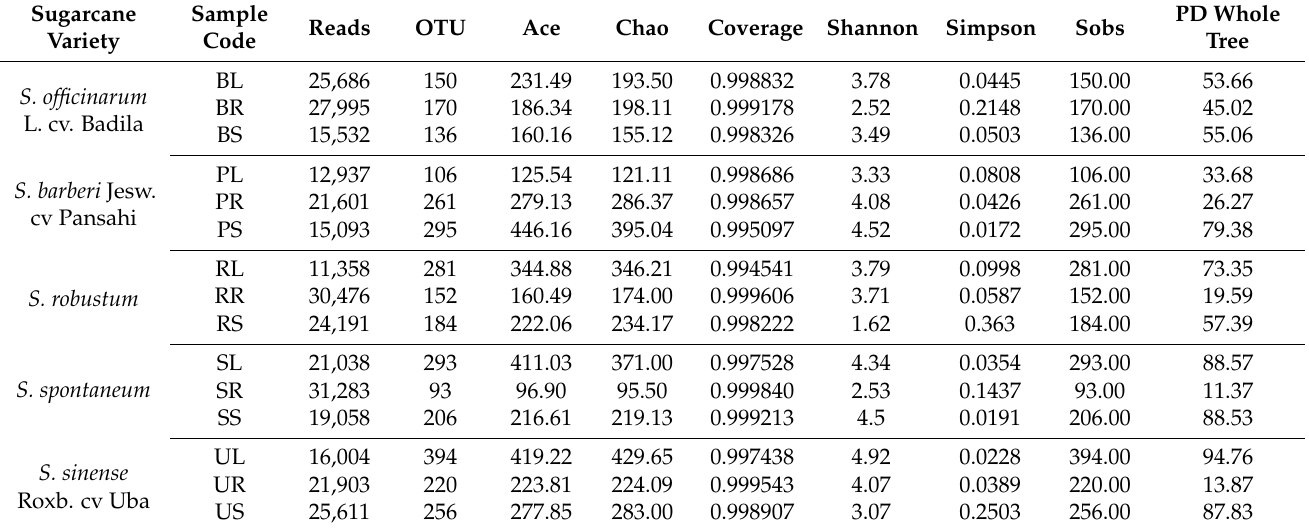
Table 3. Diversity indices for nifH gene analysis of endophytic diazotrophic bacterial communities in different tissues of five sugarcane